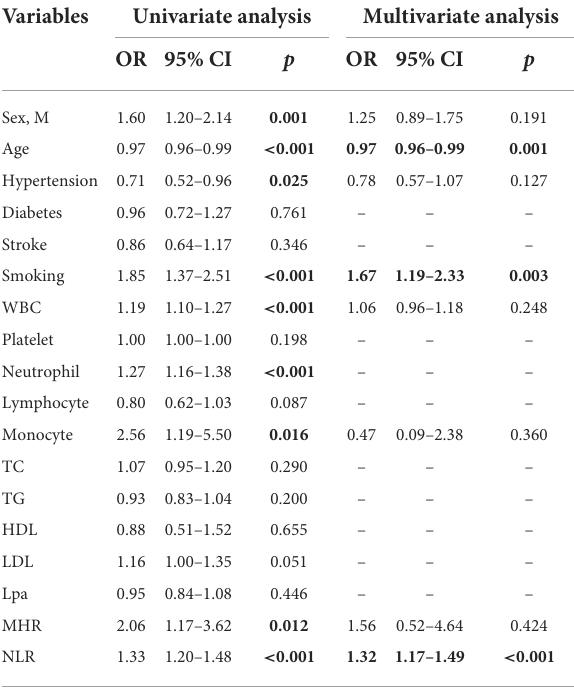
TABLE 4 Univariate and multivariate logistic regression of factors for the asymptomatic and symptomatic stenosis.